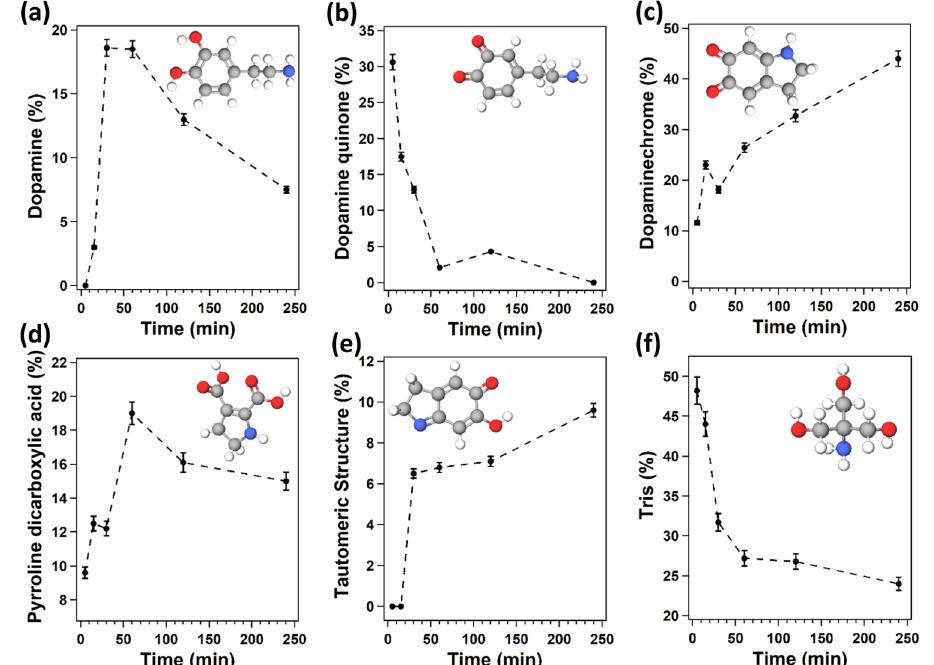
c dopaminechrome, d pyrroline carboxylic acid, e tautomeric structureand f Tris. Theerrorbarsrepresentthestandarddeviationoftheexperiments.Fordetails,see the text and Supplementary